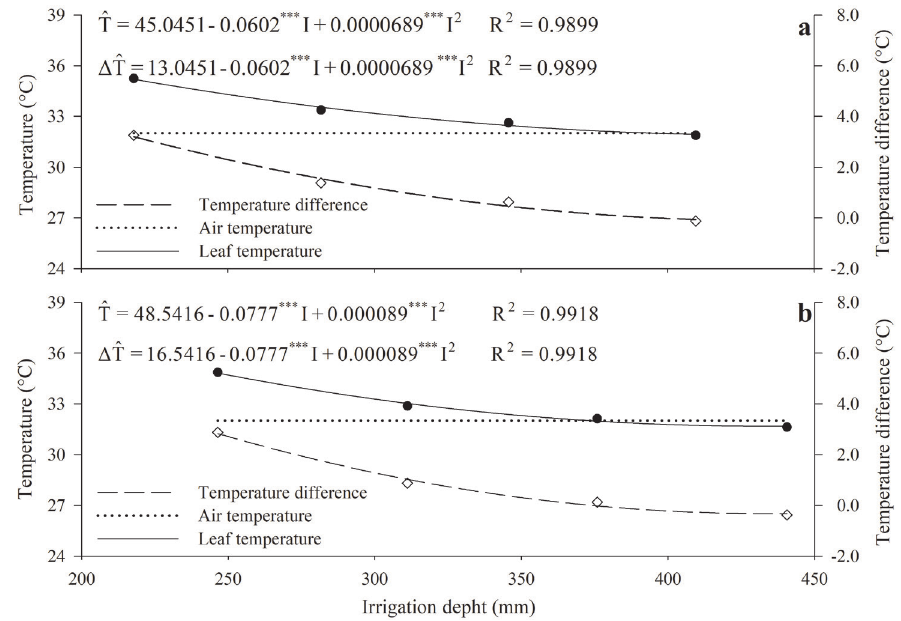
Figure 3 - Air temperature, leaf temperature (°C) and the temperature difference (°C) between the canopy and the air as a function of applied irrigation depht in the cycle of sweet potato cultivars Amanda ( a ) and Duda ( b ). *** Significant at the 1% level of the test